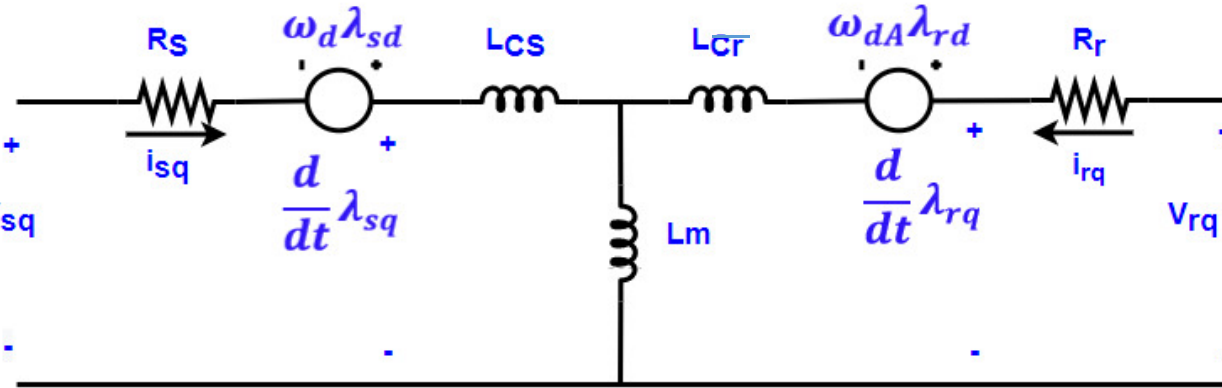
Figure 4. Induction motor equivalent circuit for the q-axis.